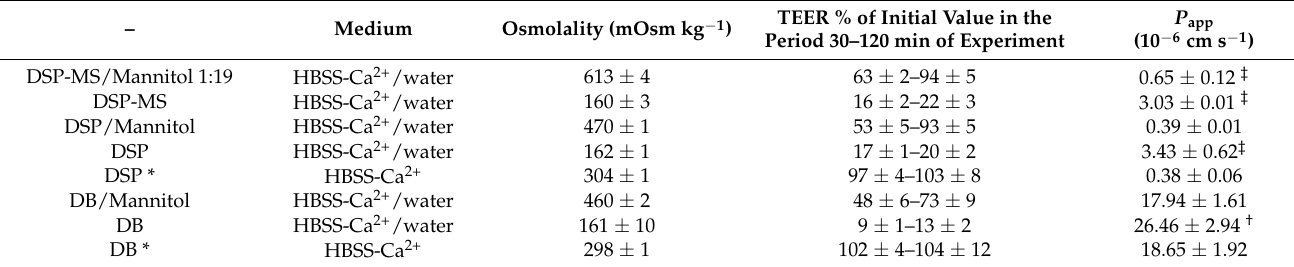
Table 3. Permeation of DSP across Calu-3 monolayer from DSP-MS suspension and DSP solution in the presence and absence of mannitol. Corresponding DB solutions were also included in the study. Apparent permeability coefficients ( P app ) of DSP and DB were presented in relation to osmolality of the test sample and TEER drop of the Calu-3 cell monolayer during permeability